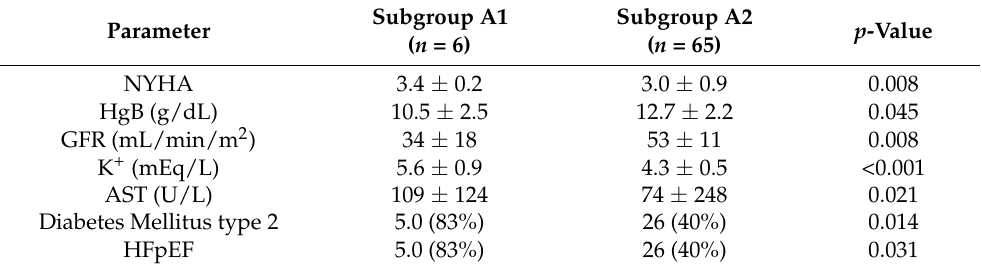
Table 4. Statistical analysis (Mann–Whitney test and Ch2 test for categorical variables) between independent characteristics and death. Subgroup A1—Ca patients who died during hospitalization. Subgroup A2—Ca patients who survived. The table presents only statistically significant correlations.